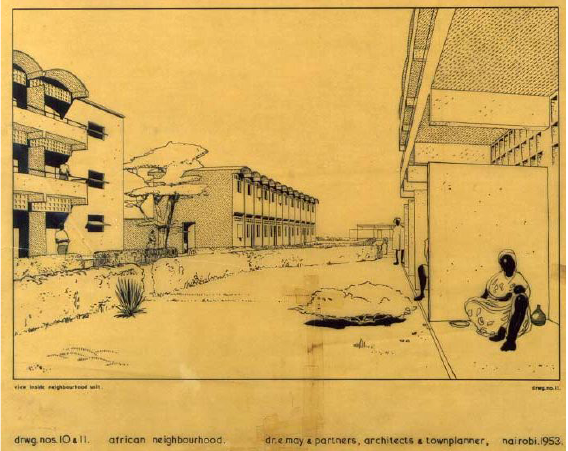
Figure 16. Ernst May, African neighborhood, Satellite Port Tudor. Source: Herrel (2001).